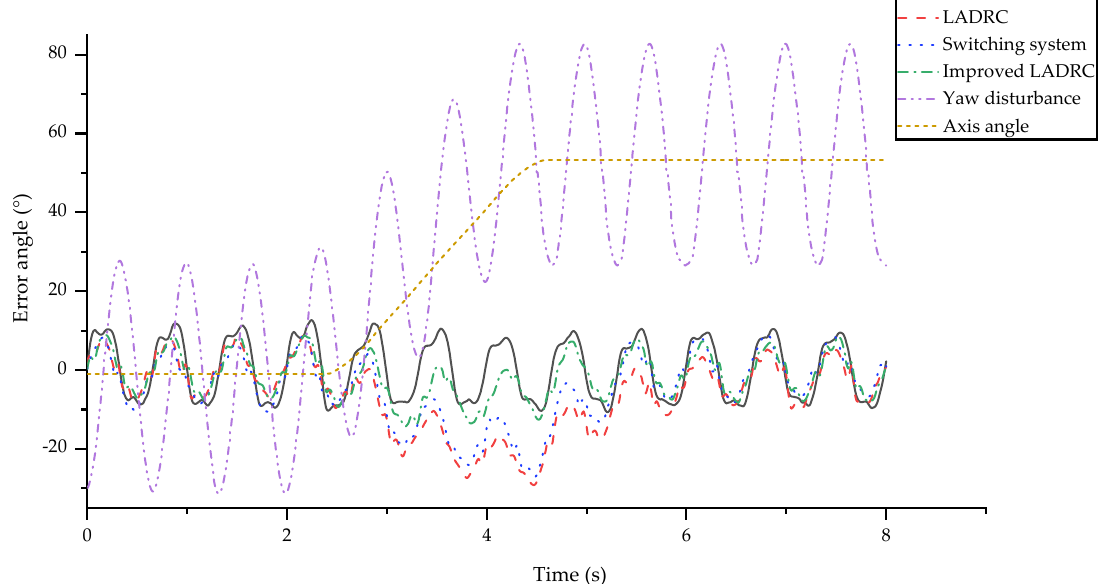
Figure 6. Experimental results of proportion differential (PD) control, LADRC, switching system, improved LADRC, yaw disturbance, and axis angle under the yaw sine wave disturbance with frequency of 1.5 Hz and amplitude of 30°, the roll sine wave disturbance with a frequency of 1.5 Hz an amplitude of 10°, and a turning speed of 25°/s.